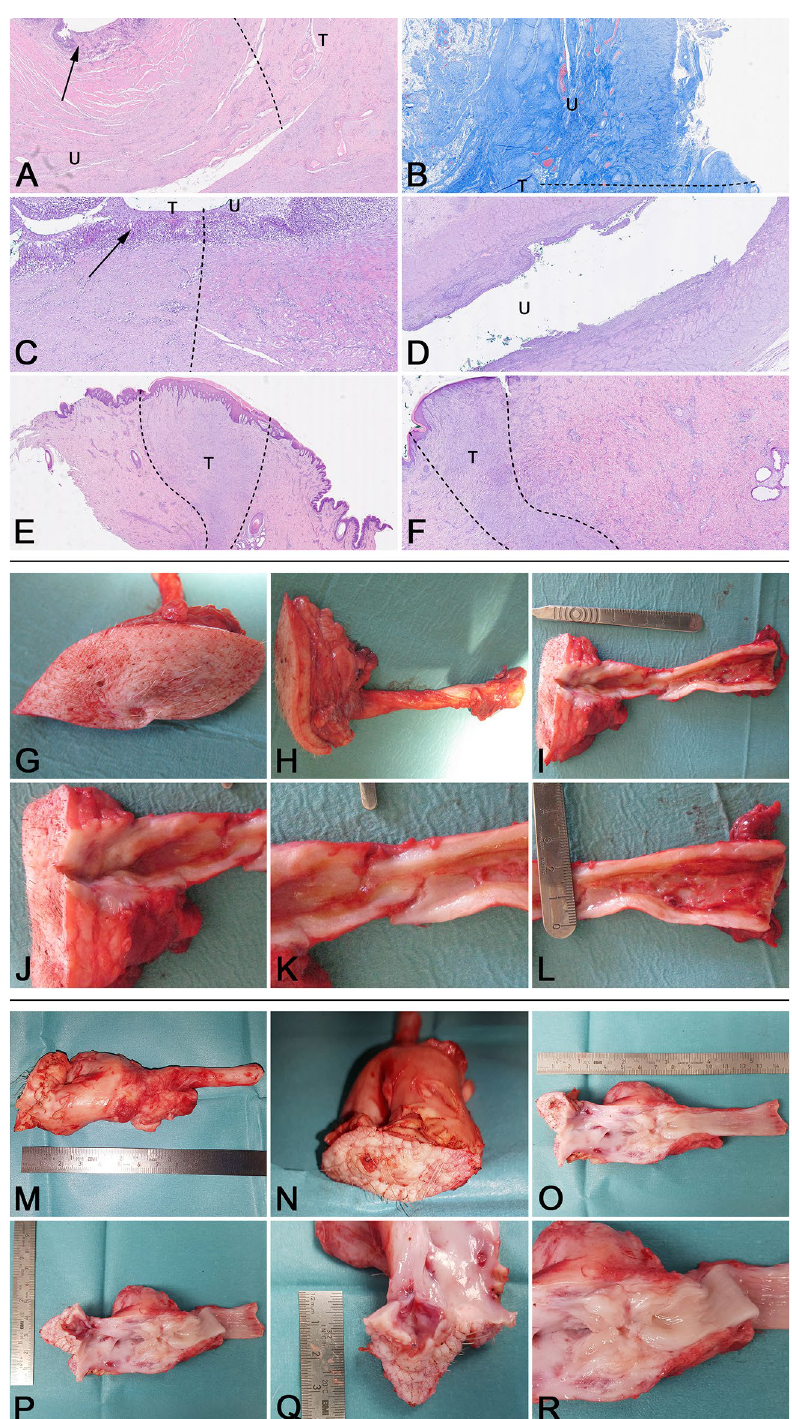
Figure 7. Histological evaluation and macroscopical examination. Samples assessment at the end of 24 weeks of observation. ( A – E ) Preimplanted Group 3: ( A – C ) ureteral anastomosis (junction between tube formed after conduit and ureter—dotted line), with arrow we marked disrupted urothelium both ureter and in a tube, ( D ) represent a destroyed ureter structure after reconstruction, ( E ) a completely urostomy overgrown, ( F ) a completely overgrown urostomy in a Group 2, the most intense inflammatory cells infiltration in the canal itself and the skin surrounding tissues. Ureterocutaneostomy in Group 1, 6 months after reconstruction. The closure of the stoma within the skin is unambiguous ( J ). Moreover, we observed distended, ureter—marked with a scalpel shaft ( K ) and shown in the photo ( L ). Pictures were taken at the end of 24 weeks of observation after a urinary diversion in a pretransplant conduit before reconstruction—Group 3. A narrowing accompanied the atresia of the skin canal in the conduit’s junction with the ureter with connective tissue growth ( O , R ). More than a significant widening of the ureter to over 2 cm with its post-inflammatory destruction ( P